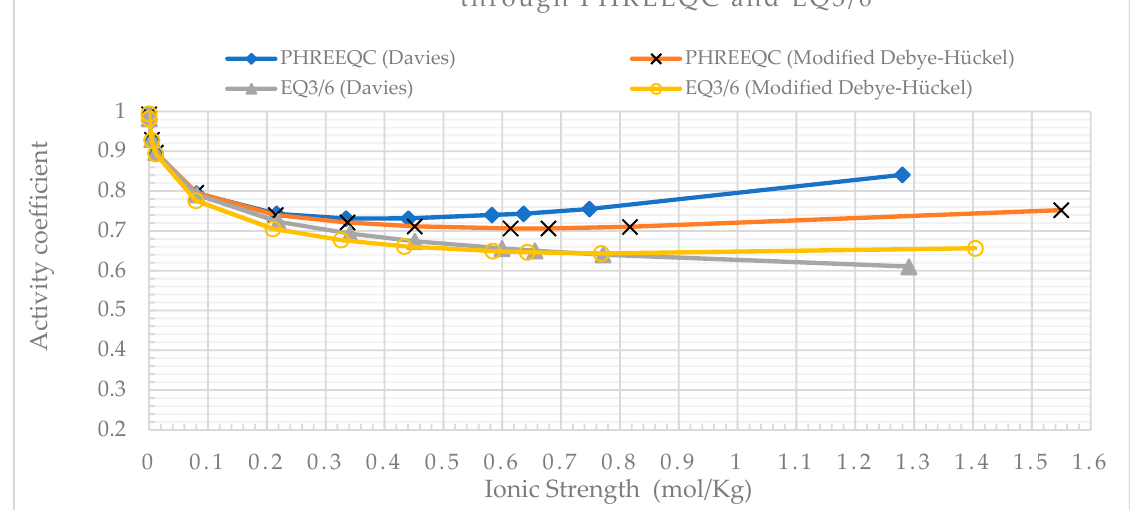
Figure 12. Comparison of the activity coefficients calculated using the Davies and modified Debye–Hückel equations through PHREEQC and EQ3/6.